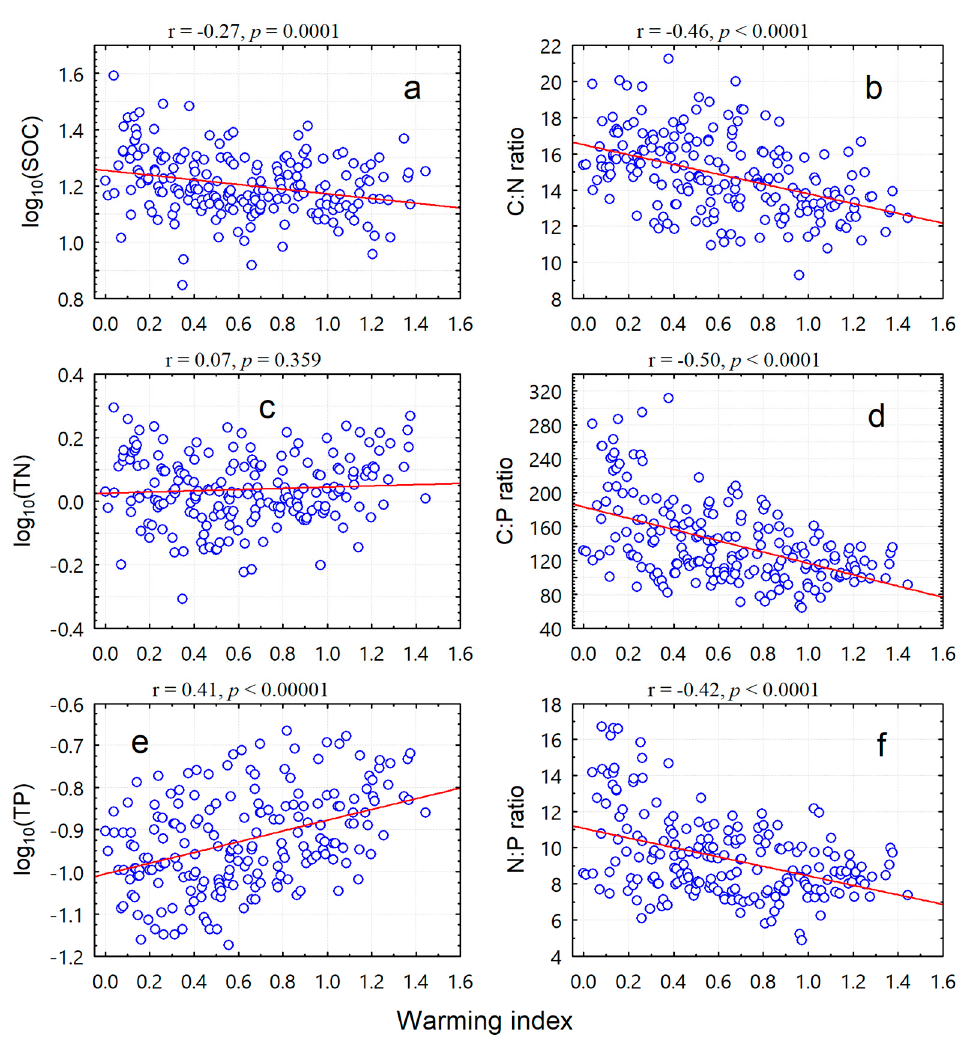
Figure 2. Relationships between the warming index and soil organic carbon (SOC; a ), total nitrogen (TN; c ), total phosphorus (TP; e ), and C:N:P stoichiometric ratios ( b , d , f ). Number of samples = 200.